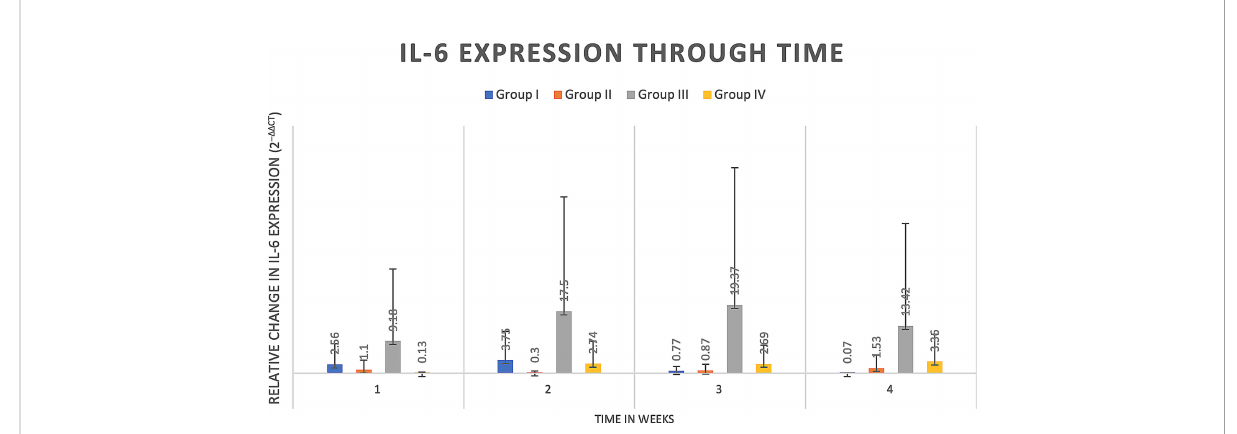
FIGURE 5 IL-6 expression through time expressed as relative fold gene expression. IL-6 expression follows a similar trend to RANKL expression, trending higher at weeks two and three and declining at week four. Data appears skewed as a result of Group III (rat 14) that had greater IL-6 expression at all timepoints although between groups there were no signi fi cant differences